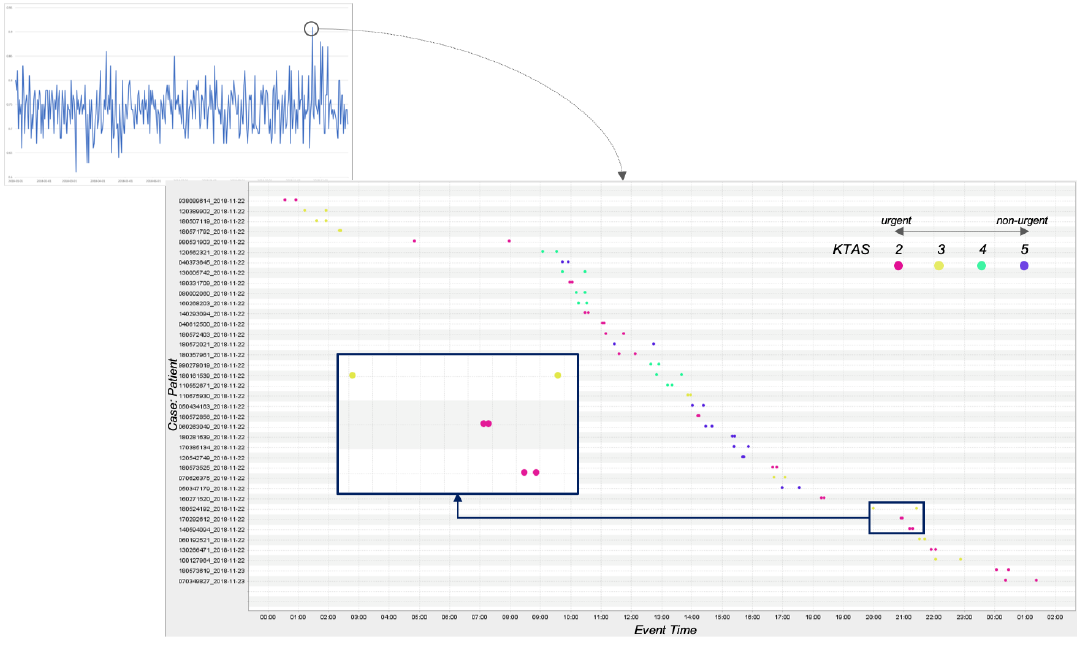
Figure 5. The triage-based patient response analysis